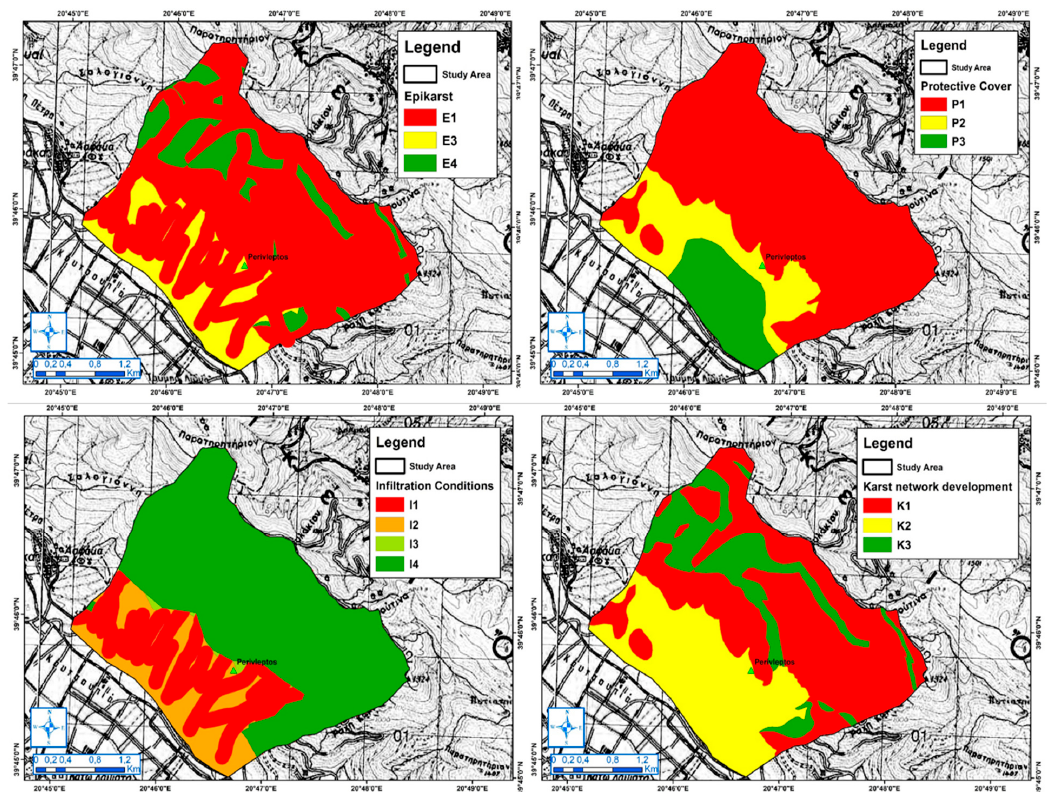
Figure 5. Thematic maps of parameters E, P, I, K. (The Epikarst, Protective Cover, Infiltration Conditions and Degree of Karstic Network Development (EPIK) Method).